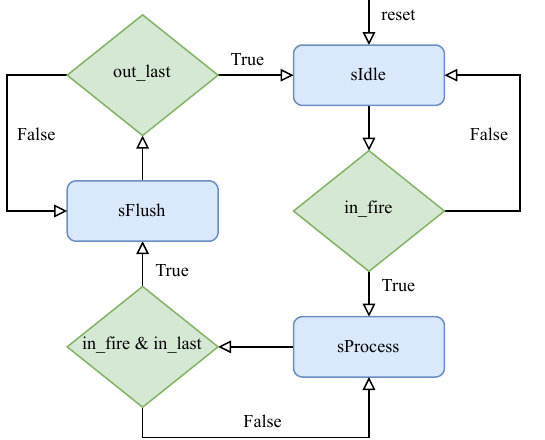
Figure 9. Simplified state machine that controls data flow of the SDF-FFT. Some signals are omitted for